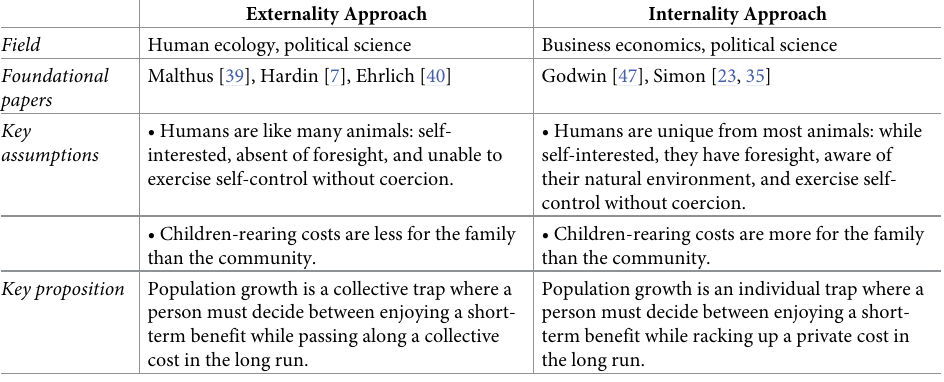
Table 1. A summary and comparison of the two approaches to the social dilemma of self-control, cooperation, and human population growth. Externality